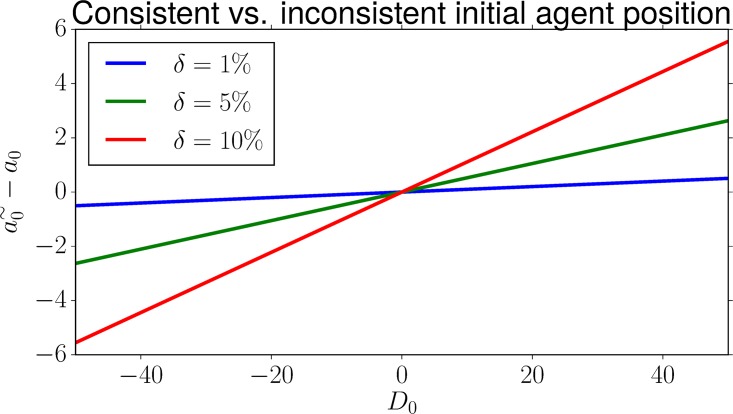
Difference between the inconsistent and the actual initial agent position, when observing the tangent reference velocity after 1%, 5% or 10% of the entire trajectory length.